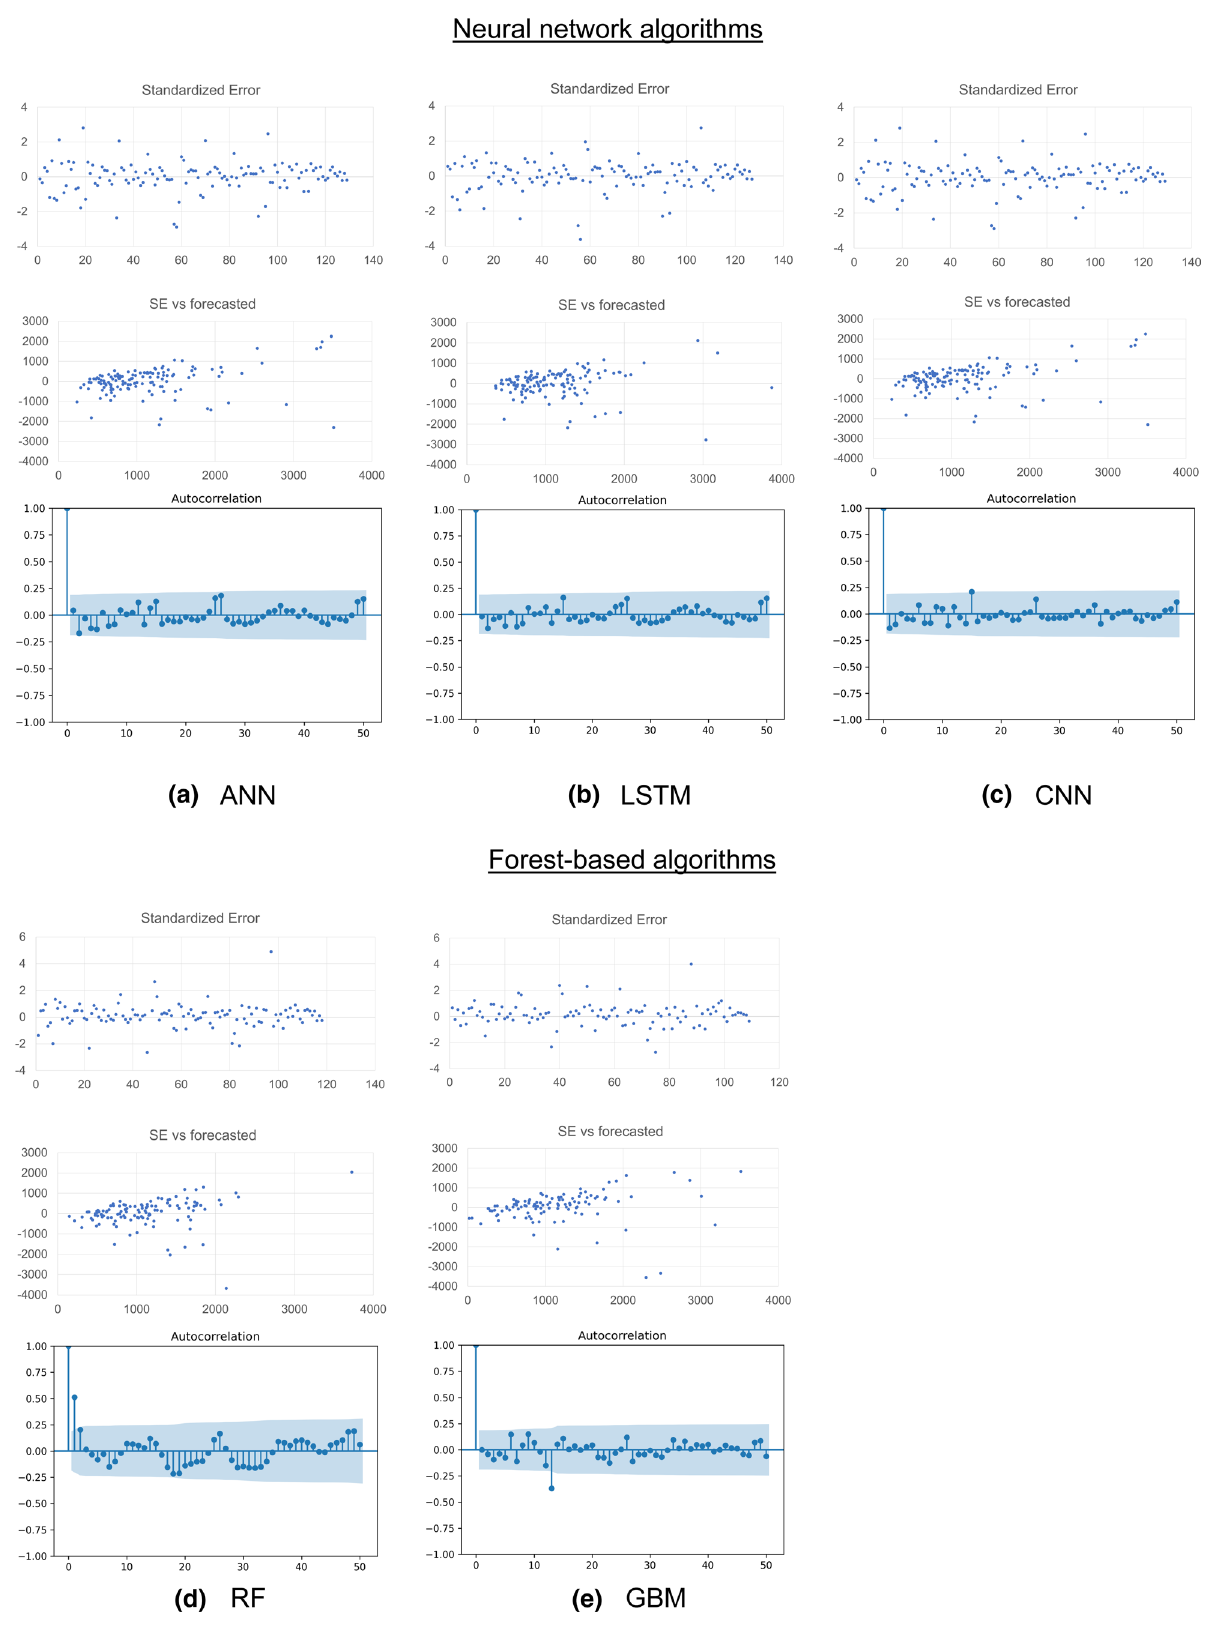
Fig. 11 Residual analysis of the standardized error, standardized error against streamflow forecast, and ACF plot of the machine learning